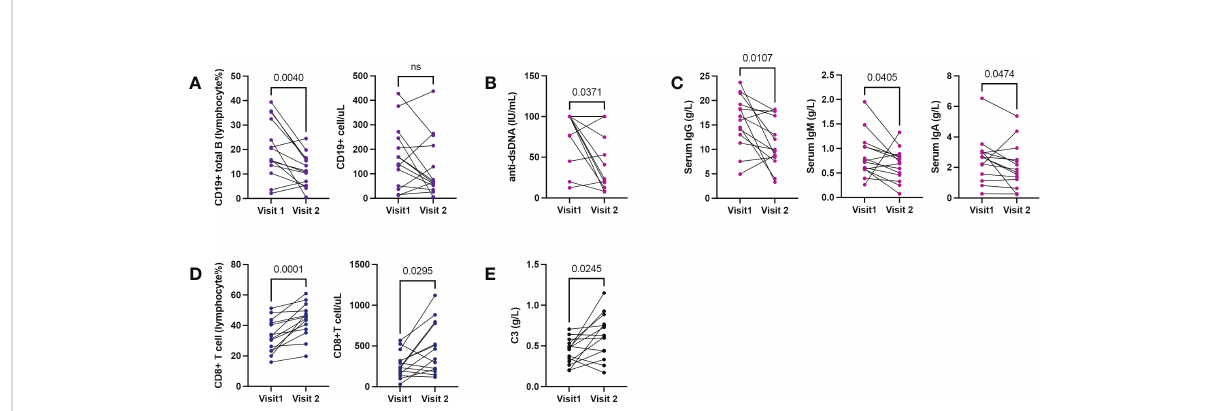
FIGURE 4 Shifting immune phenotypes in longitudinal records of active SLE. 14 patients with repeated hospitalizations due to active lupus (each hospitalization with SLEDAI ≥ 8). (A) Changes in B cell counts and proportions. (B, C) Changes in serum anti-dsDNA and serum immunoglobulin levels. (D) Changes in CD8+T cell counts and proportions. (E) Changes in serum C3. Wilcoxon-test for all